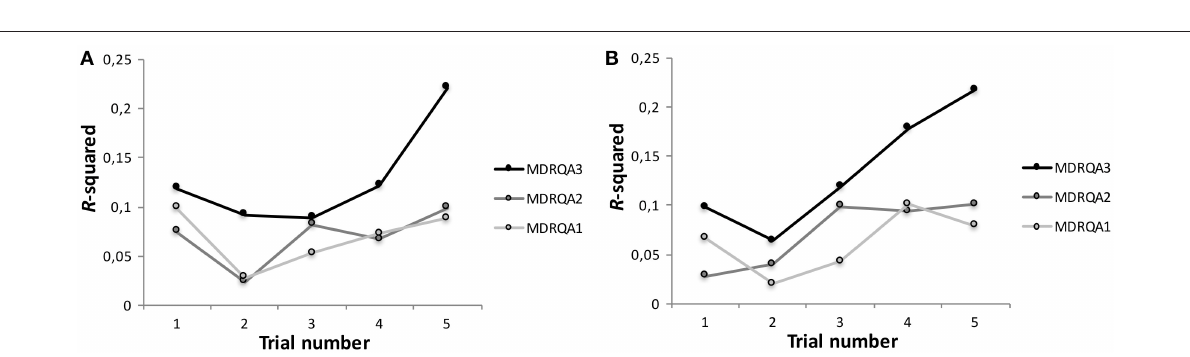
FIGURE 7 | R 2 of a simple regression model using RR, DET, ADL, and LDL as predictors for (A) the number of successfully built origami boats and (B) the number of unsuccessful attempts during each of the five trials for average individual dynamics (MdRQA1), average dyadic dynamics (MdRQA2), and group-level dynamics (MdRQA3). As all regression models had the same number of degrees of freedom (predictor DF = 4, residual DF = 95), a significant model at α = 0.05 had to explain at least 9.6% of variance ( R 2 = 0.096), i.e., all models with R 2 > 0.096 are significant at p <